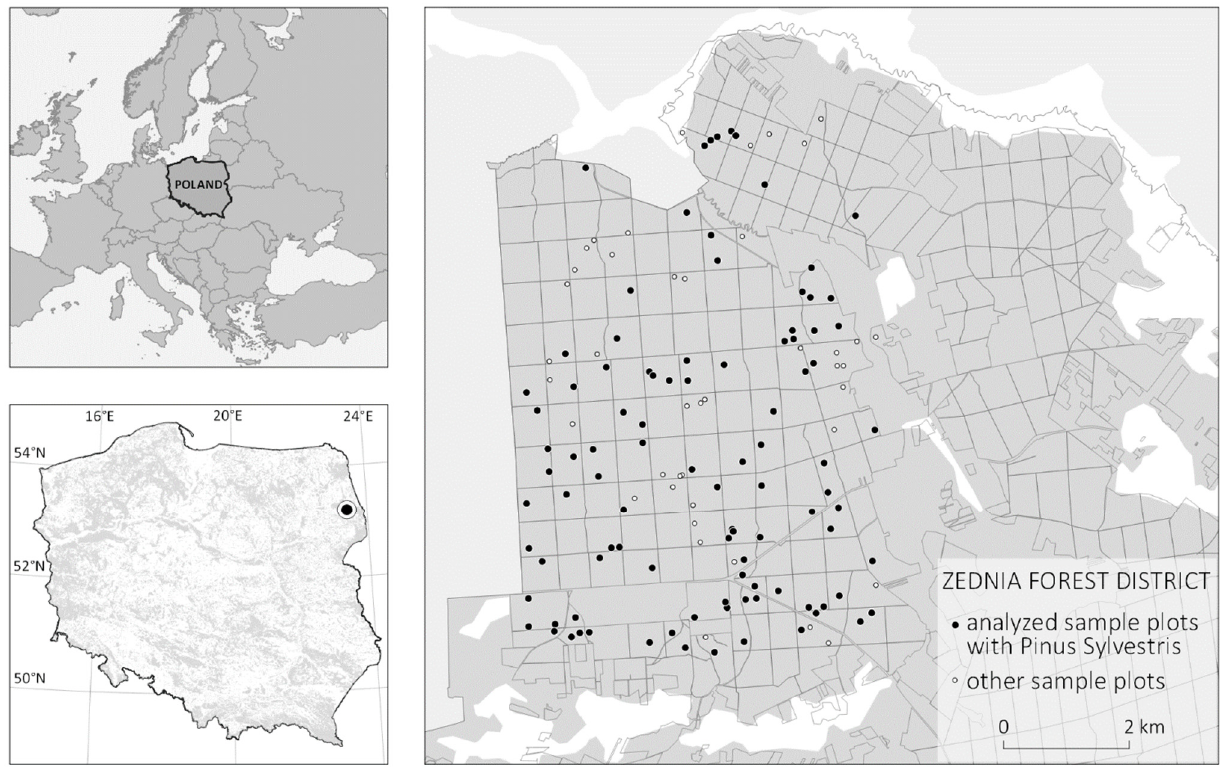
Figure 1. The study area is located in Northeastern Poland (Central Europe). The bottom left map presents territory of Poland with the distribution of forested areas in gray and the marked location of Zednia Forest District. The map on the right presents the ground sample plots which are distributed across the Zednia Forest